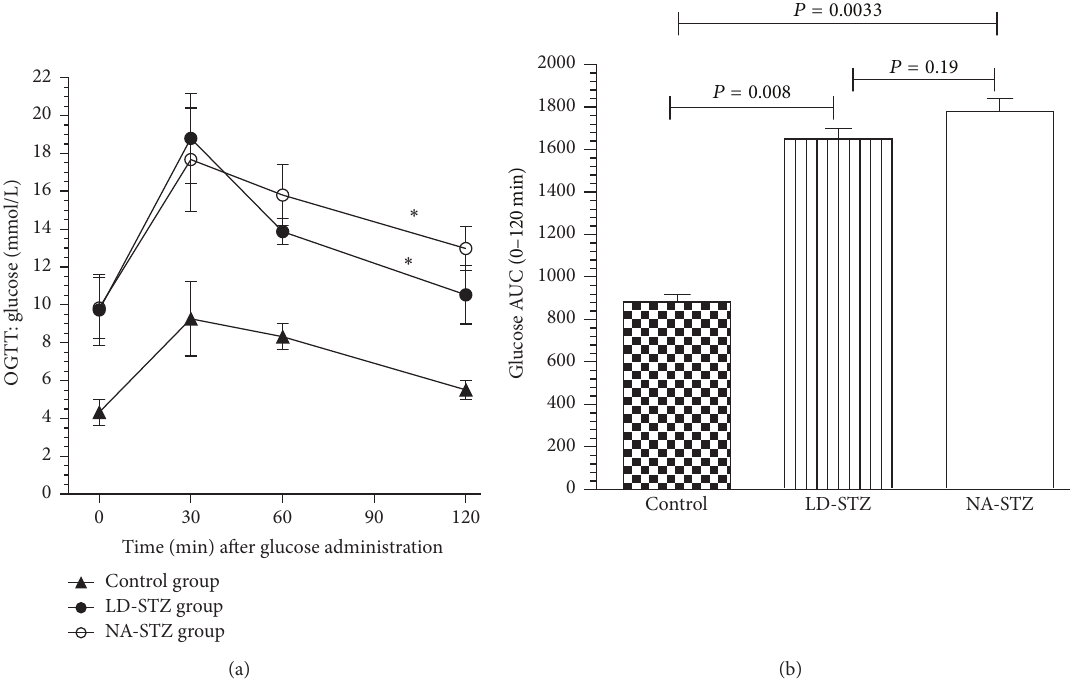
Figure 4: Glucose curves of oral glucose tolerance tests (OGTTs) and area under the curves (AUC) of glucose in the experimental groups. (a) Plasma glucose responses to oral administration of glucose in dose of 3 g/kg during 120min OGTTs in the control (nondiabetic rats) and groups with diabetes being induced one week earlier (at week 8 of the experiment) by intraperitoneal injections of either a low dose of streptozotocin (LD-STZ) or nicotinamide and streptozotocin (NA-STZ). ∗ 𝑃 < 0.01 compared to control nondiabetic group. Nonsignificant difference between NA-STZ and LD-STZ groups is not shown. (b) Total glucose area under the curves (AUC) is presented for comparison between experimental groups. Mean values and standard deviations are